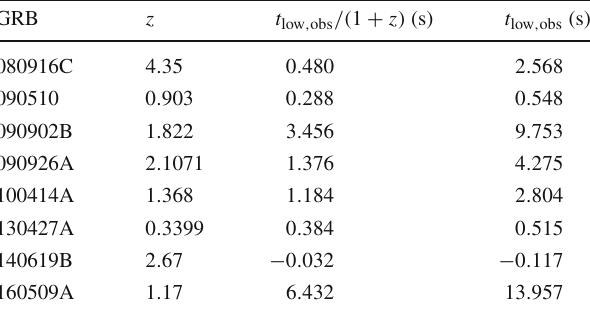
Table 5 The low energy characteristic times we recommend (using Criterion 3) for 8 GRBs GRB